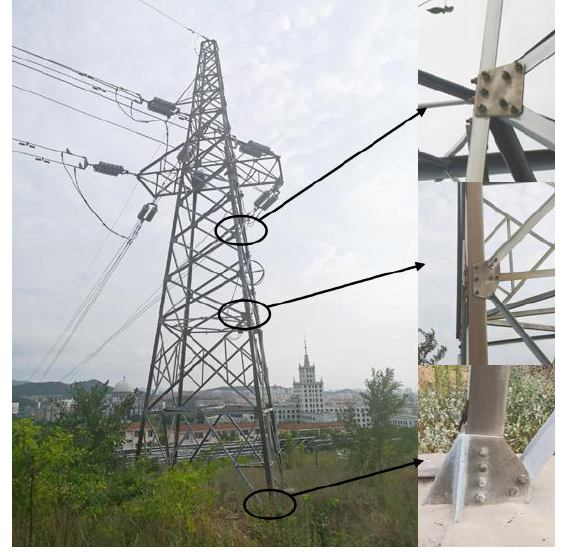
Figure 2: Actual angle joint of transmission tower